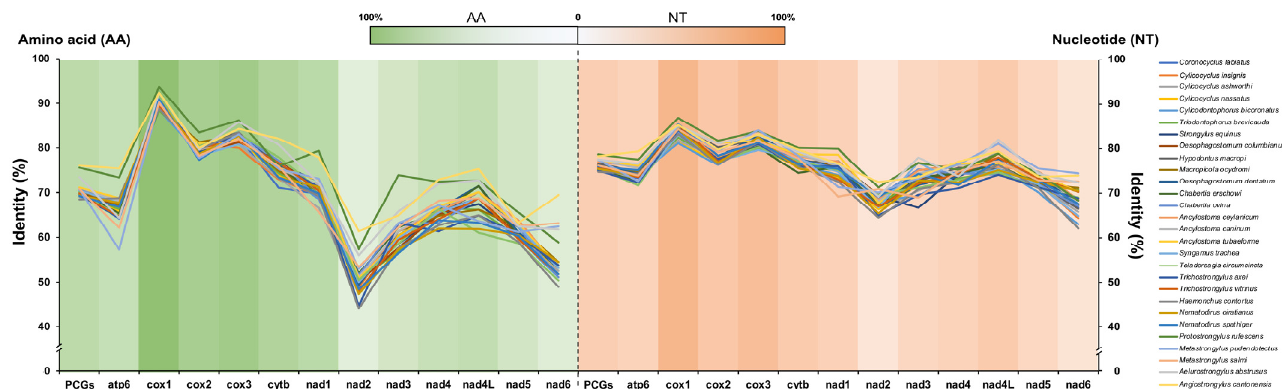
Figure 5. Identity comparison of PCGs for 28 related Strongylida species with V. eleguneniensis . Different species are indicated by different colored broken lines. The heat maps in green and orange represent the average values of sequence identities of amino acid and nucleotide datasets, respectively.